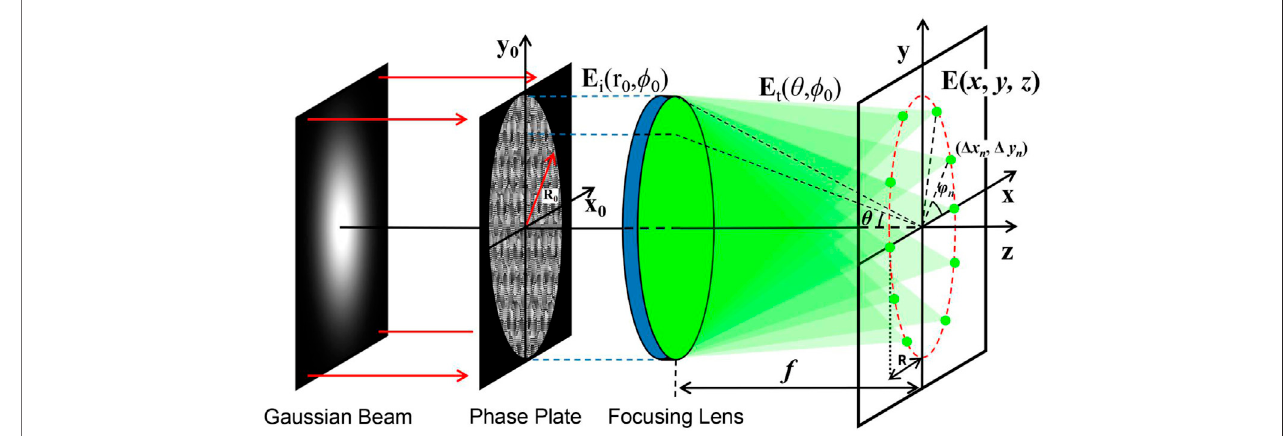
FIGURE 1 | Schematic diagram of the MFI method in a tightly focused